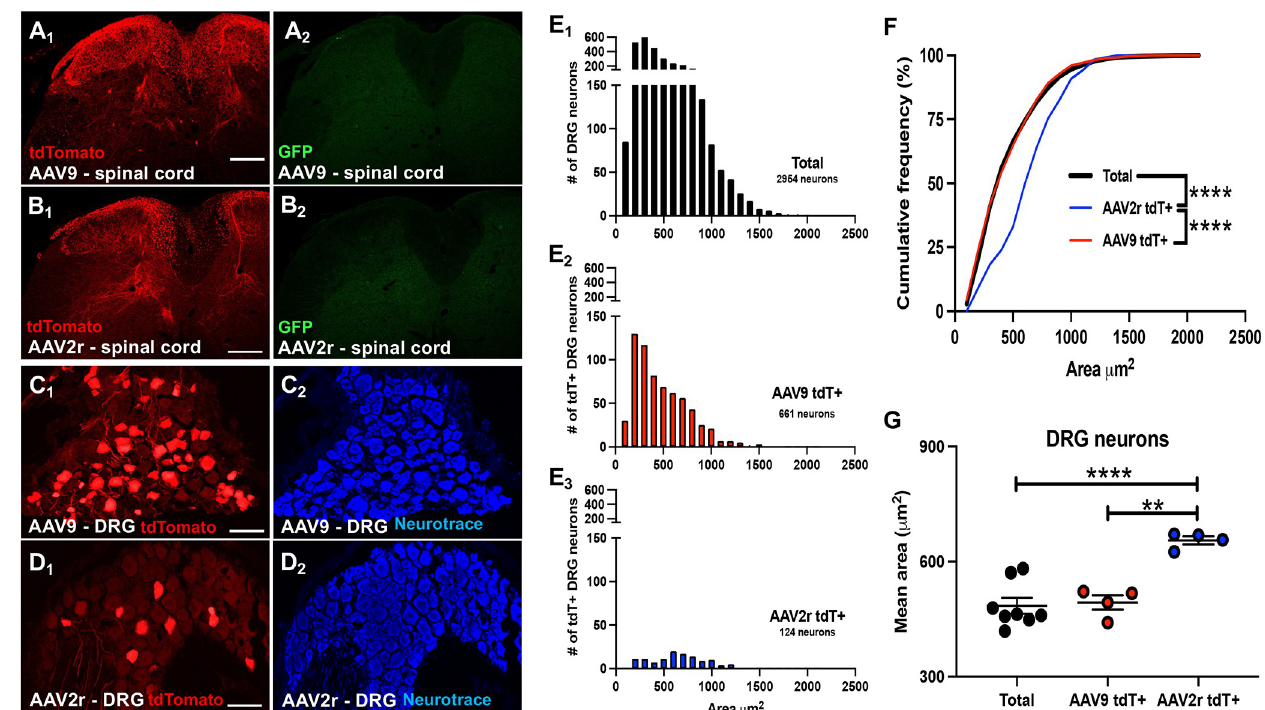
Fig 3. Transduction of spinal cord and DRG neurons following intrathecal delivery of AAV9 and AAV2retro. A and B, tdTomato (red, subscript 1) and GFP (green, subscript 2) immunofluorescence in the lumbar spinal cord of mice injected with AAV9 (A) or AAV2retro (B); scale bars = 200 μ m. C and D, tdTomato (red, subscript 1) immunofluorescence and NeuroTrace staining (blue, subscript 2) showing transduced neurons in L4 DRG following injection of AAV9 (C) or AAV2retro (D); scale bars = 100 μ m. E , NeuroTrace (C2, D2) was used to quantify the area of individual L4 DRG neurons. The areas of total (E1), AAV9 transduced tdTomato+ (E2), and AAV2retro transduced tdTomato+ (E3) DRG neurons are shown as frequency histograms to illustrate the number of DRG neurons relative to their area ( μ m 2 ). F, The cumulative frequency distribution plot of DRG neuron area shows that while the size distribution of AAV9 tdT+ DRG neurons (red line) closely matches that of total NeuroTrace labeled DRG neurons (black line; Kolmogorov-Smirnov test, p > 0.05), the size distribution of the AAV2retro tdT+ DRG neuron population (blue line) is skewed toward larger cells compared to both the total DRG neuron population, and the AAV9 tdT+ DRG neuron population, with 66.35% of the total DRG neuron population and 59.84% of the AAV9 tdT+ DRG neuron population comprised of neurons with an area � 500 μ m 2 , while only 33.06% of the AAV2r+ DRG neuron population has an area � 500 μ m 2 (Kolmogorov-Smirnov test, ���� = p < 0.0001). G , Each dot represents the mean area of DRG neurons from a single animal (n = animal #). The mean area of AAV2retro tdT+ DRG neurons is significantly larger than the mean area of total, and AAV9 tdT+, DRG neurons (Welch’s one-way ANOVA with Dunnet’s T3 multiple comparisons test �� = p < 0.01; ���� = p <